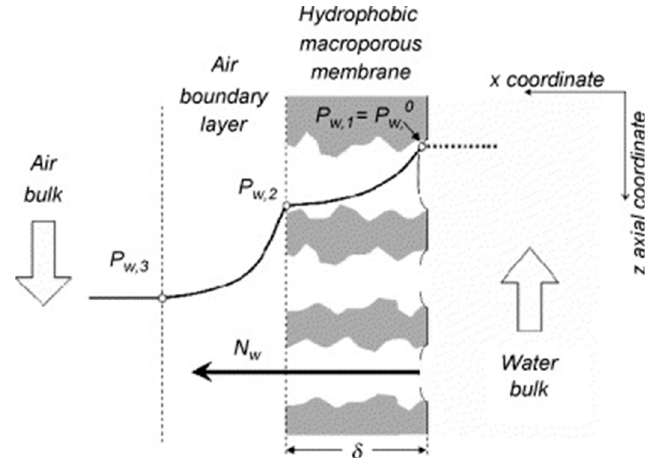
Figure 8. Water vapour pressure profiles in the membrane evaporation (ME) process. Reprinted from “Study of a new membrane evaporator with a hydrophobic metallic membrane” [19], © 2006, with permission from Elsevier.